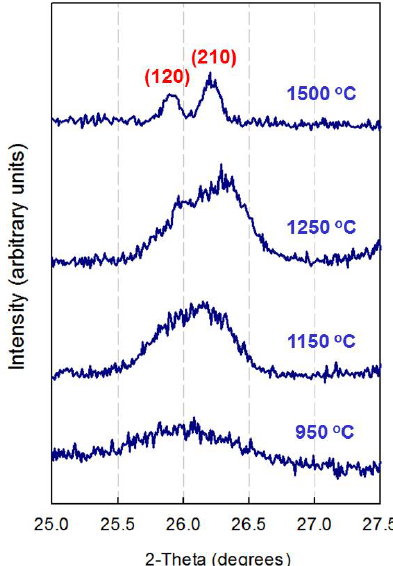
Figure 5. Splitting of the (120) and (210) peak pair in the XRD diffractogram of mullite with increasing calcination temperatures.